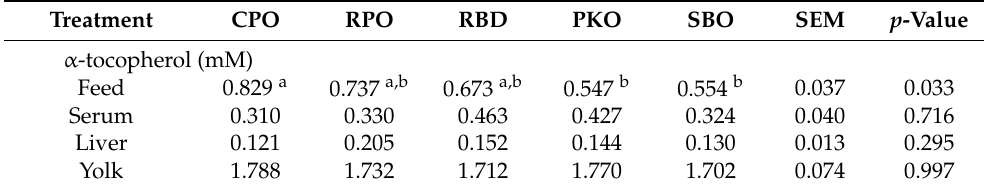
Table 7. Feed, liver, serum and yolk α -tocopherol profiles in laying hens fed different